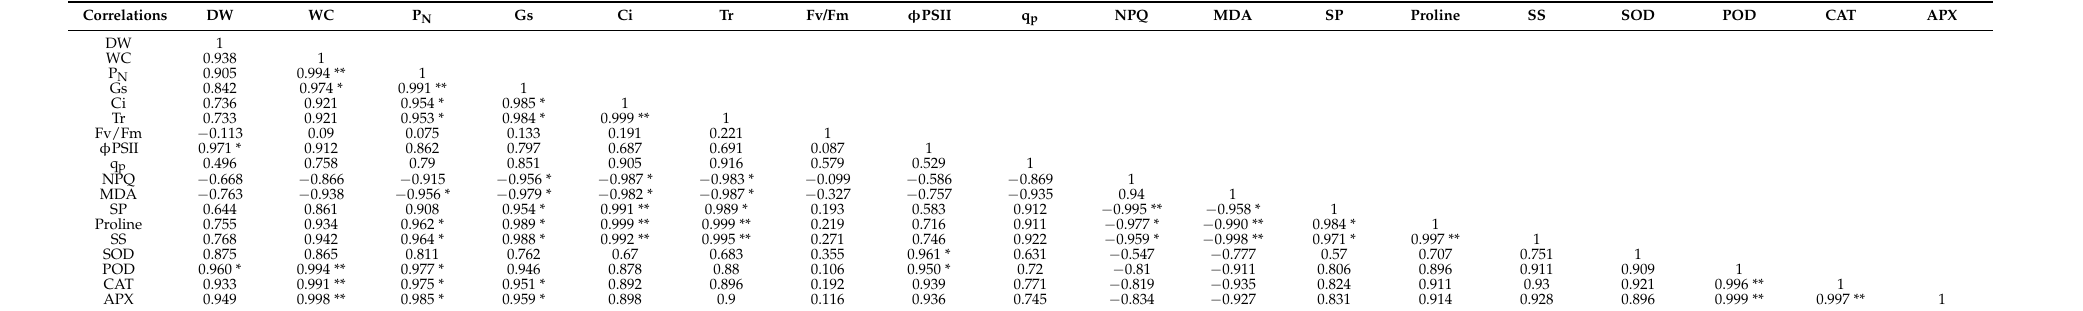
Table A2. Correlation analysis of physiological indexes under drought stress lasting for 5 days (D1).